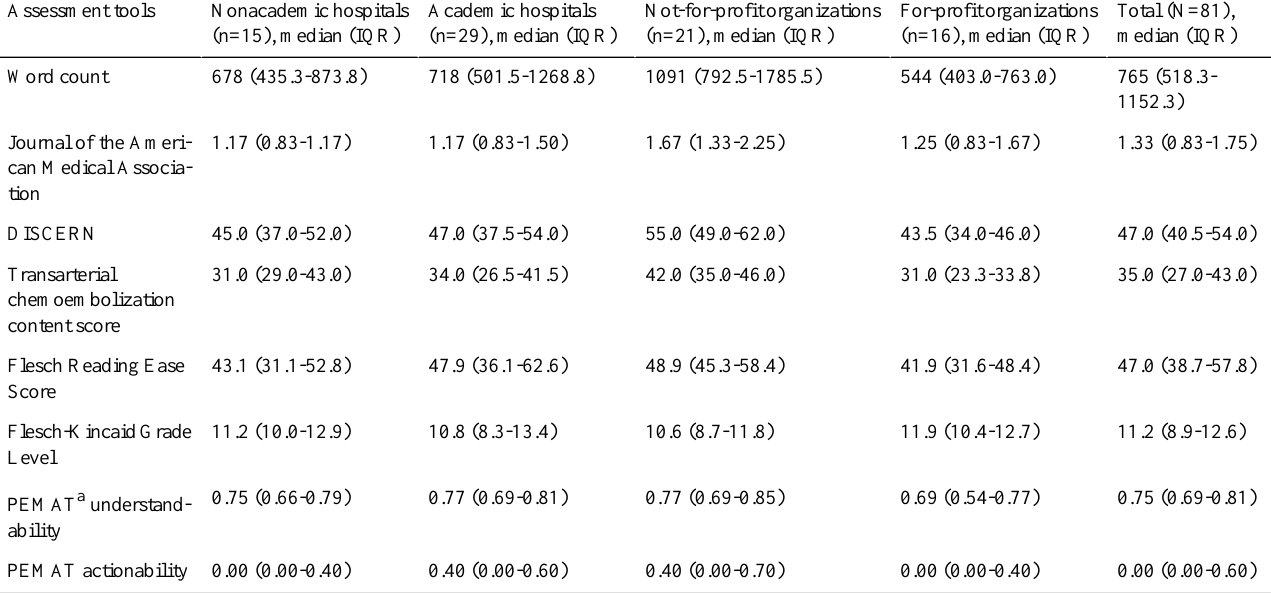
Table 1. Assessment results per website category and overall. (IQR)Assessment tools